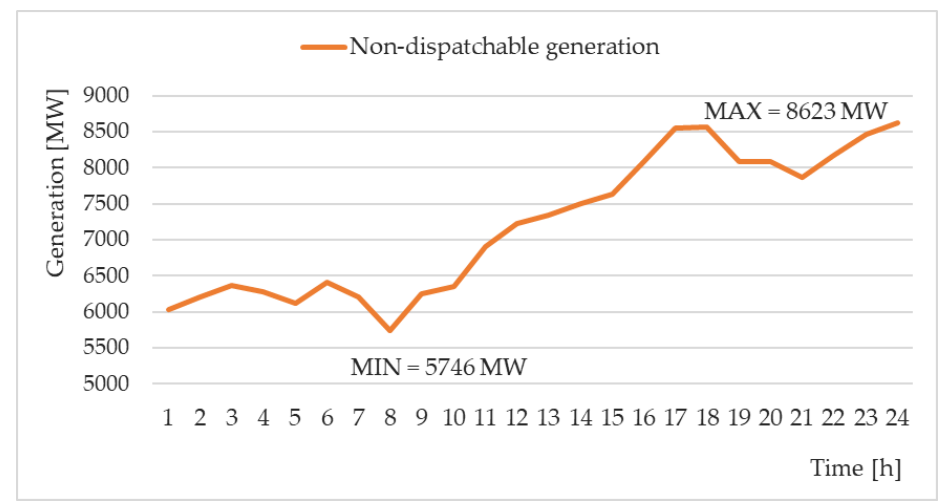
Figure 5. The assumed fixed profile of non-dispatchable generation. Data source [36].